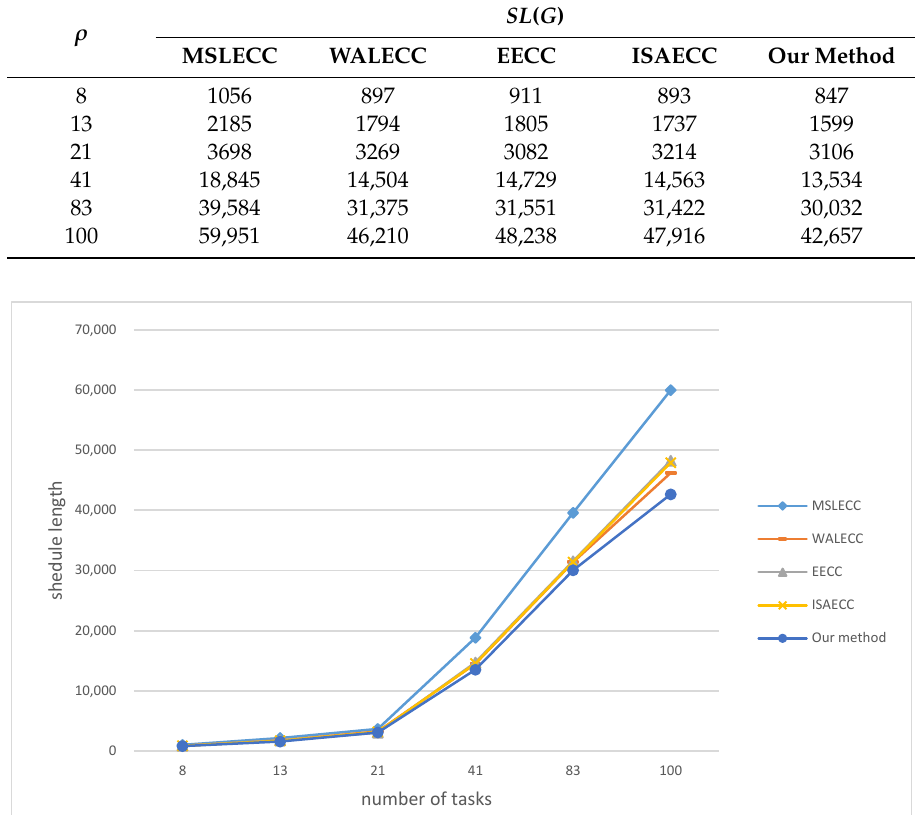
Table 7. Results of GE applications for varying number of tasks.